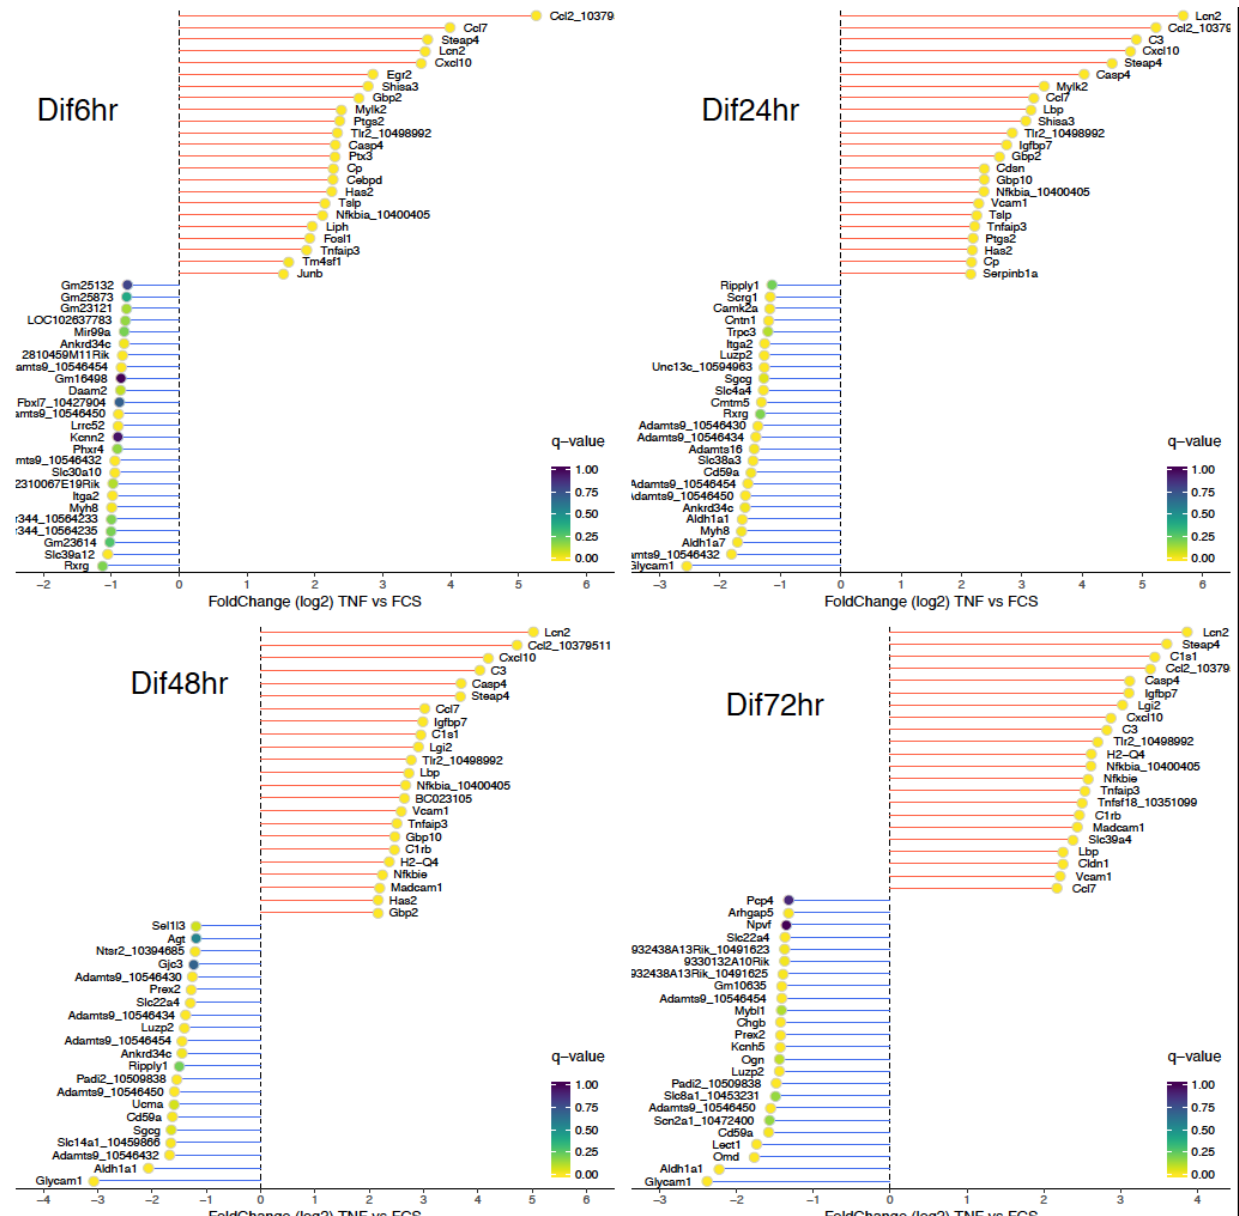
Figure 2. Snake plot. Top 25 and bottom 25 genes were extracted according to the log 2 fold change value and plotted on the y -axis. Each gene dot is filled with its q -value and using the viridis color gradient (viridis R package, GarnierSversion0.4.0. https://CRAN.Rproject.org/package=viridis, accessed on 5 April 2021). Gene symbols are reported next to each dot.